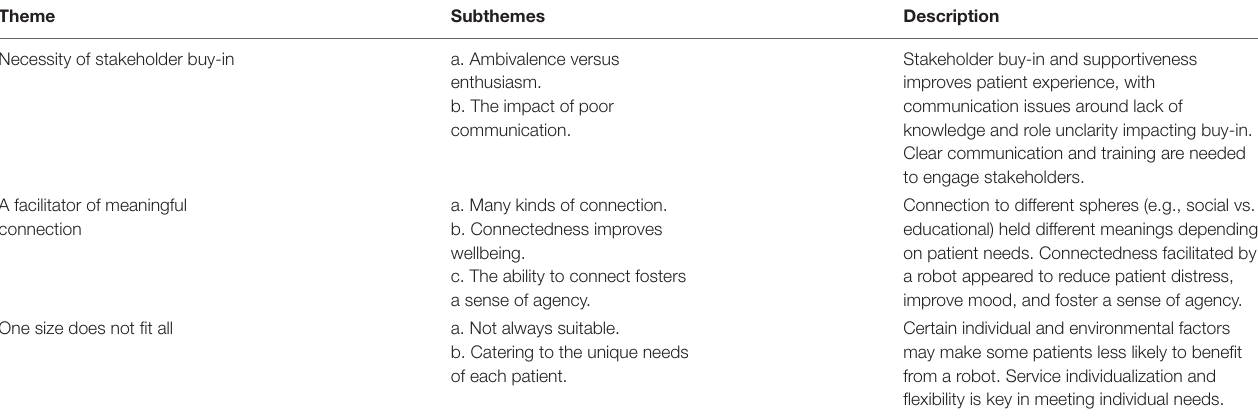
TABLE 2 | Phase II themes and